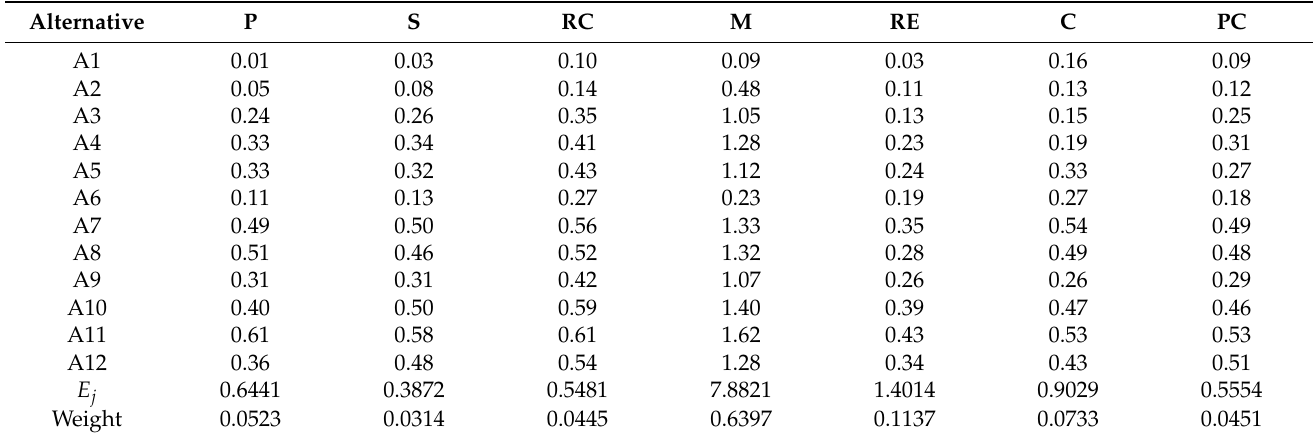
Table 3. Weight calculations using